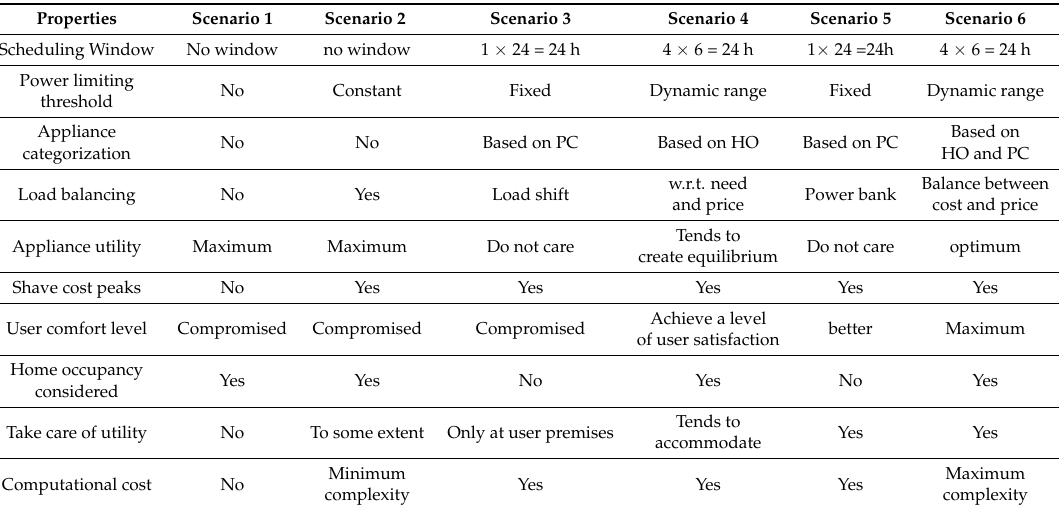
Table 5. Performance analysis of major EMS